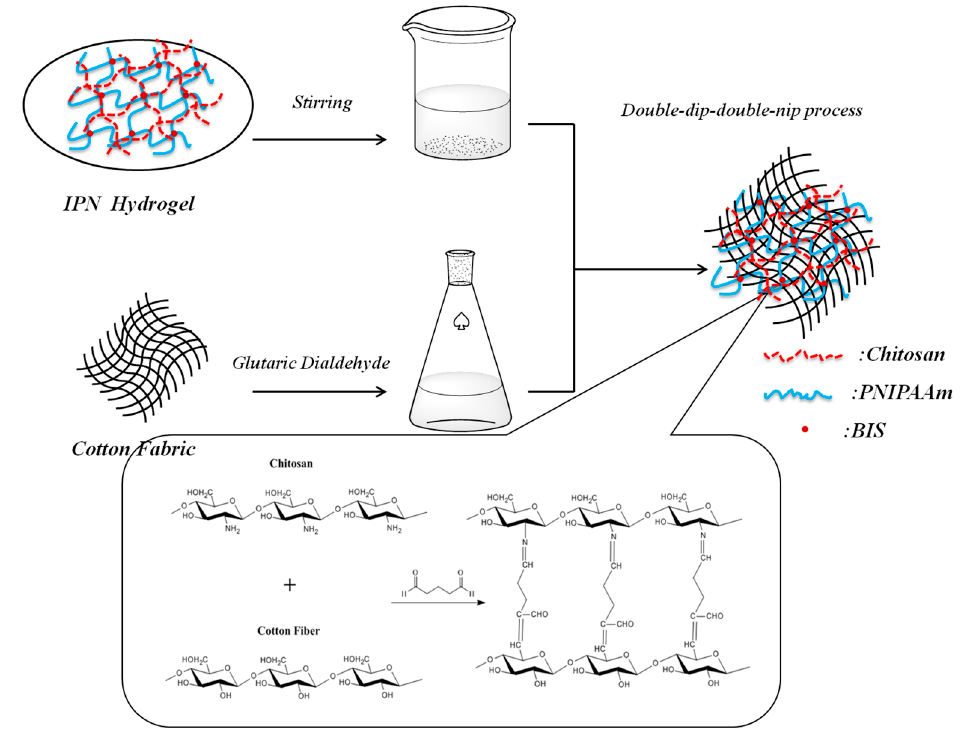
Figure 2. Cross-linking reaction of IPN hydrogel and cotton fabric.